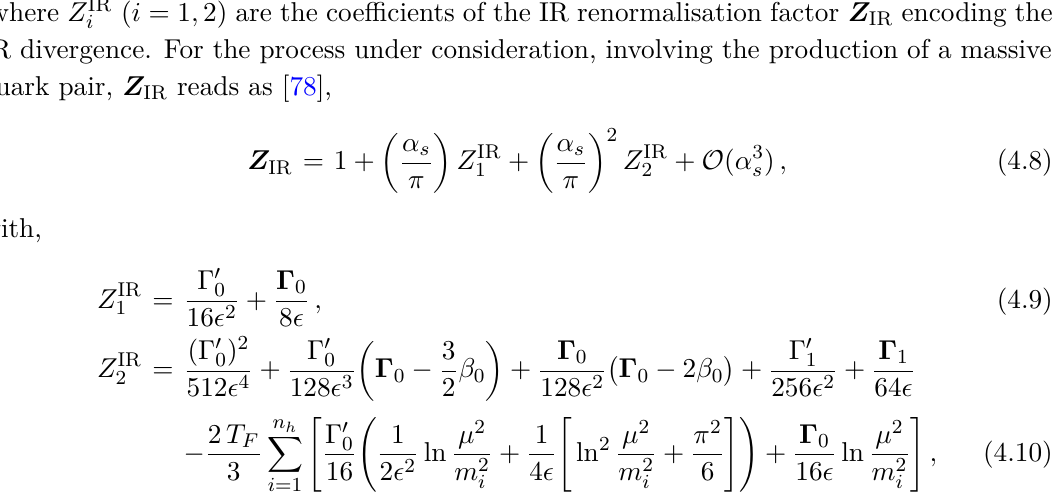
Figure 10 . Three-dimensional plots of the finite terms M ( n ) and two-loop amplitudes, in eqs. (2.9), (2.10), where N